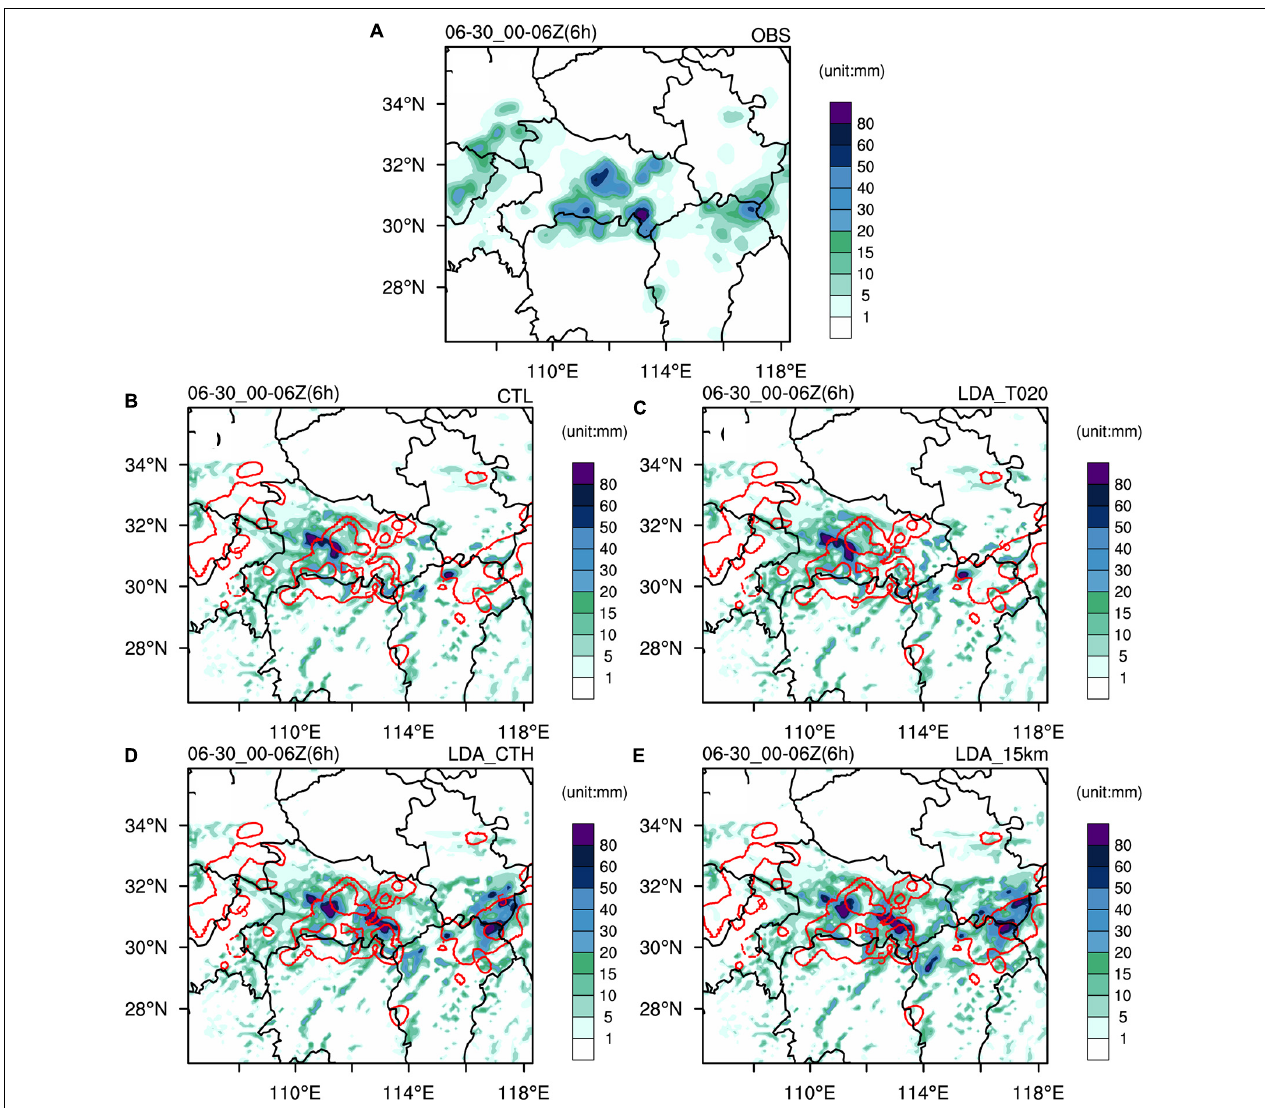
FIGURE 11 | Observations and forecasted 6-h accumulated precipitation from 0000 UTC to 0600 UTC on 30 June for each experiment. (A) Observations (OBS), (B) CTL, (C) LDA_T020, (D) LDA_CTH, and (E) LDA_15km. The contours for observations (5 mm, 30 mm) are highlighted with red lines in the panels for LDA experiments (B–E)